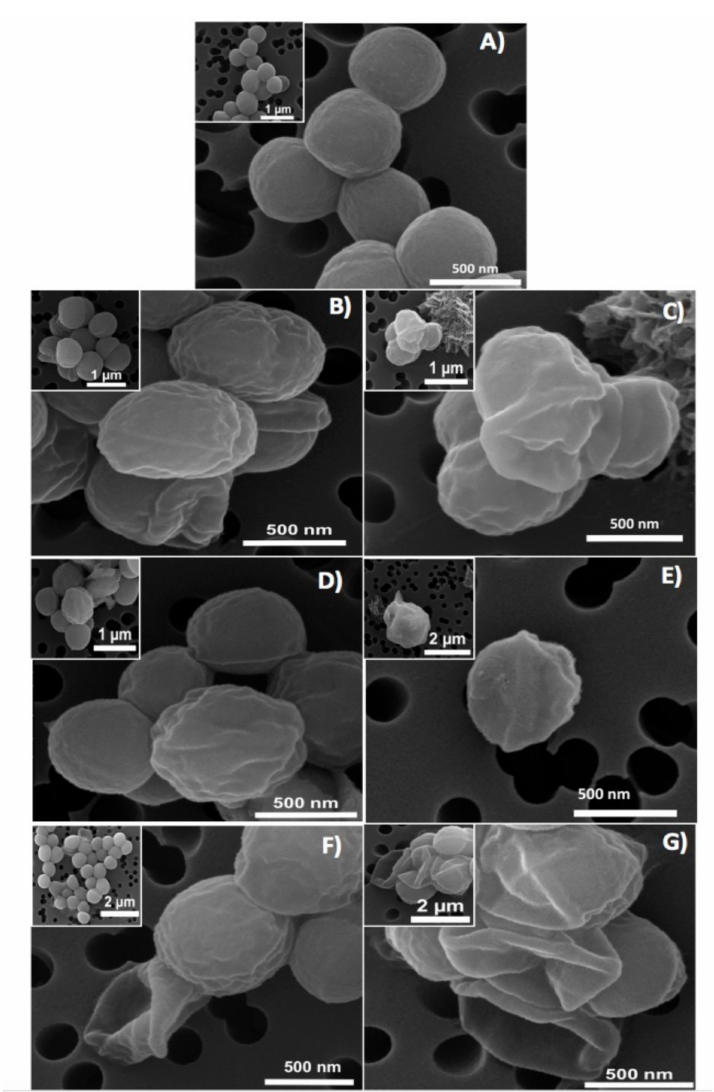
Figure 1. Scanning electron microscopy (SEM) images of S. aureus ( A ) untreated (control sample); treated bacteria during 24 h with MIC of ( B ) carvacrol; ( D ) cinnamaldheyde; ( F ) thymol; treated bacteria during 24 h with MBC of ( C ) carvacrol; ( E ) cinnamaldheyde; ( G )